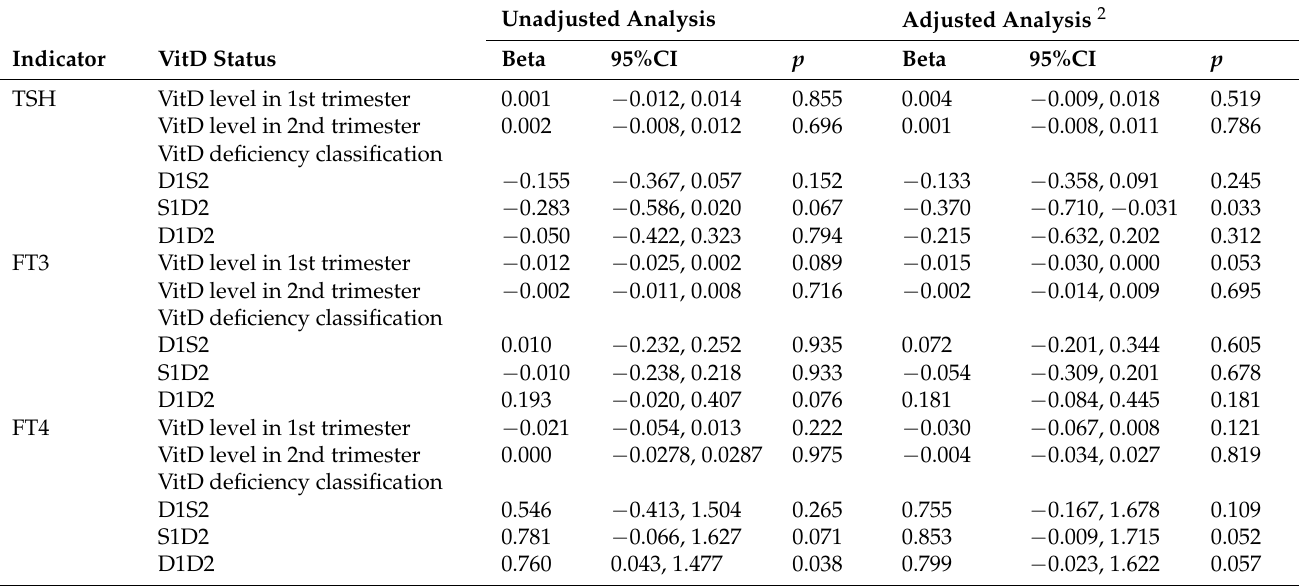
Table 4. Associations between VitD status and thyroid function parameter across three trimesters 1 ( n =